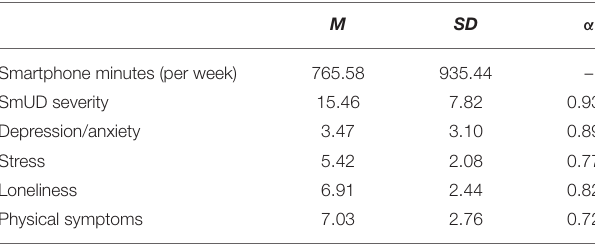
TABLE 1 | Means, standard deviations, and Cronbach’s alpha. M SD